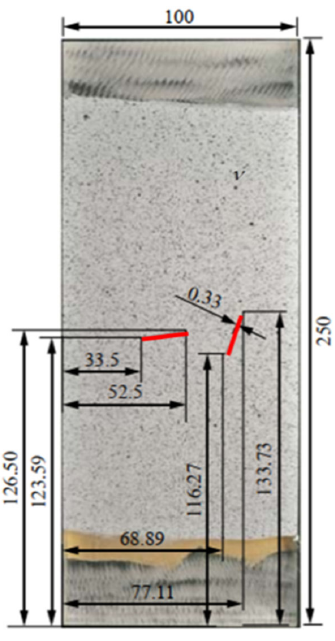
Figure 3. Schematic diagram of the pre-crack position [15]. The red solid line in Figure 3 shows the position of the prefabricated crack. Parameters of the plexiglass are presented in Table 1. Table 1. Material parameters of